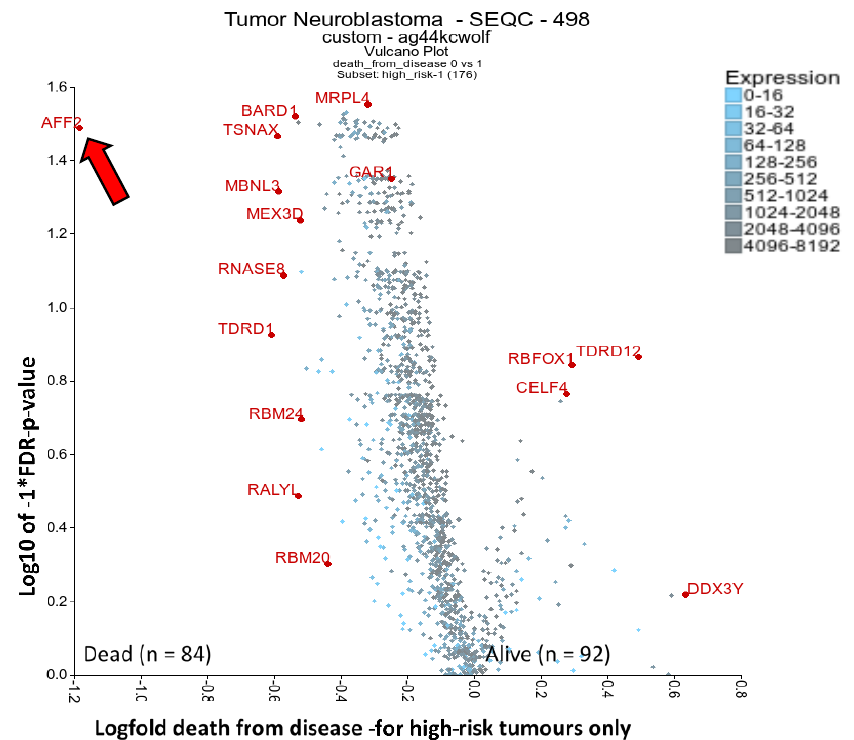
Figure 2. Differential expression of RBPs, analysing occurrence of death (from disease) in high-risk disease. The RBP gene list from Gerstberger et al. 2014 [17] was used filter for RBPs and then compare A) high-risk tumours only, comparing surviving or dead individuals. This was displayed as a volcano plot using the two groups plotter option of the R2 visualisation tool (https: // r2.amc.nl). The SEQC-498 cohort with the custom normalisation option was used on the R2 platform (GEO accession: GSE49710). Clearly outlying genes have been annotated where possible. mRNAs had to have a minimum of 50 expression units and be present in 50 tumours analysed. Statistical analysis was conducted with the Kruskal rank-based test, and FDR correction of p-values was performed. The arrow highlights AFF2 next to y -axis.